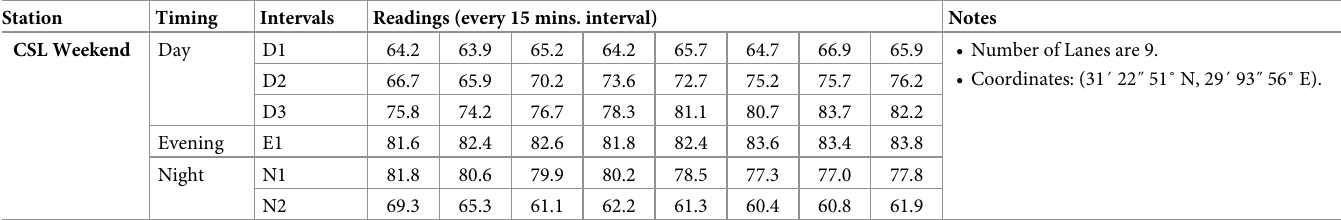
Table 10. The data sheet for Cleopatra Station (CLS) showing the noise level readings that were taken at the station on the selected intervals during weekend. Station Timing Intervals Readings (every 15 mins. interval)